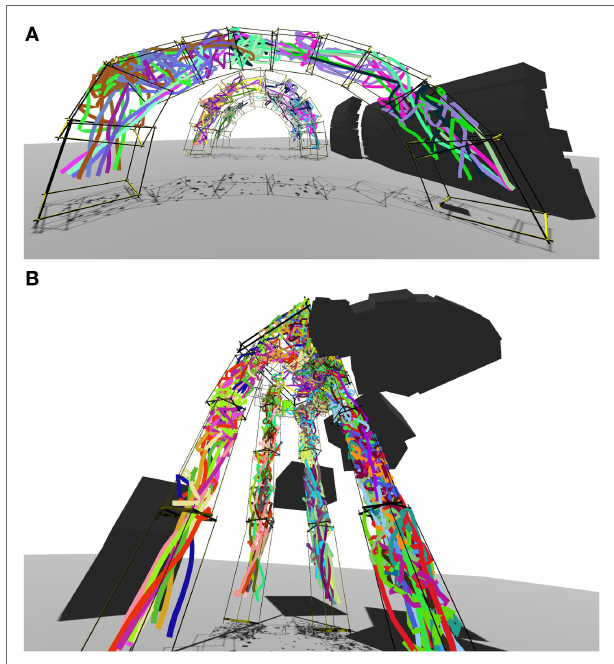
FigUre 13 | Braiding volumes are arranged as (a) arcs and (B) columns to guide the building swarms of agents (Wagner et al.,